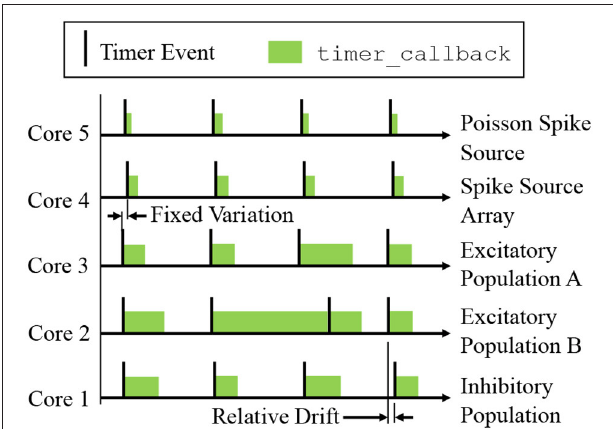
FIGURE 5 | Time-driven updates by neuron cores simulating the network in Figure 3B : periodic timer events trigger callbacks advancing neuron states by 1 t . Cores can be out of phase due to communication of the start signal, and relative drift can occur due to manufacturing variability between boards. Note that state update times vary with the level of additional spike processing within a simulation timestep, however cores which experience high levels of spike activity delaying the subsequent timer_callback can catch up during subsequent periods of lower spike activity (as shown by Core